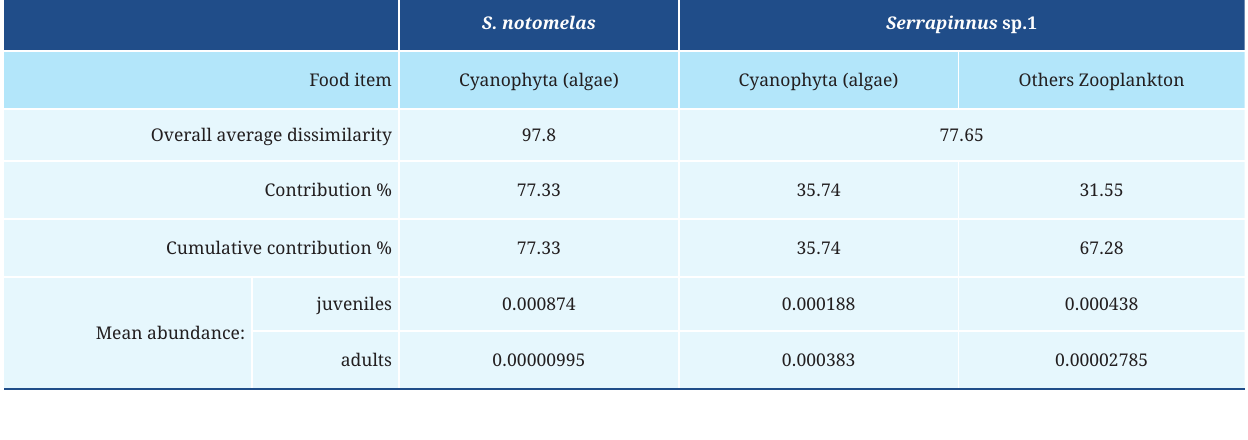
TABLE 2 | Results of the dissimilarity analysis (SIMPER) for the proportion of food items of Serrapinnus notomelas and Serrapinnus sp.1 between juveniles and adults in a lake in the upper Paraná River floodplain, Brazil.